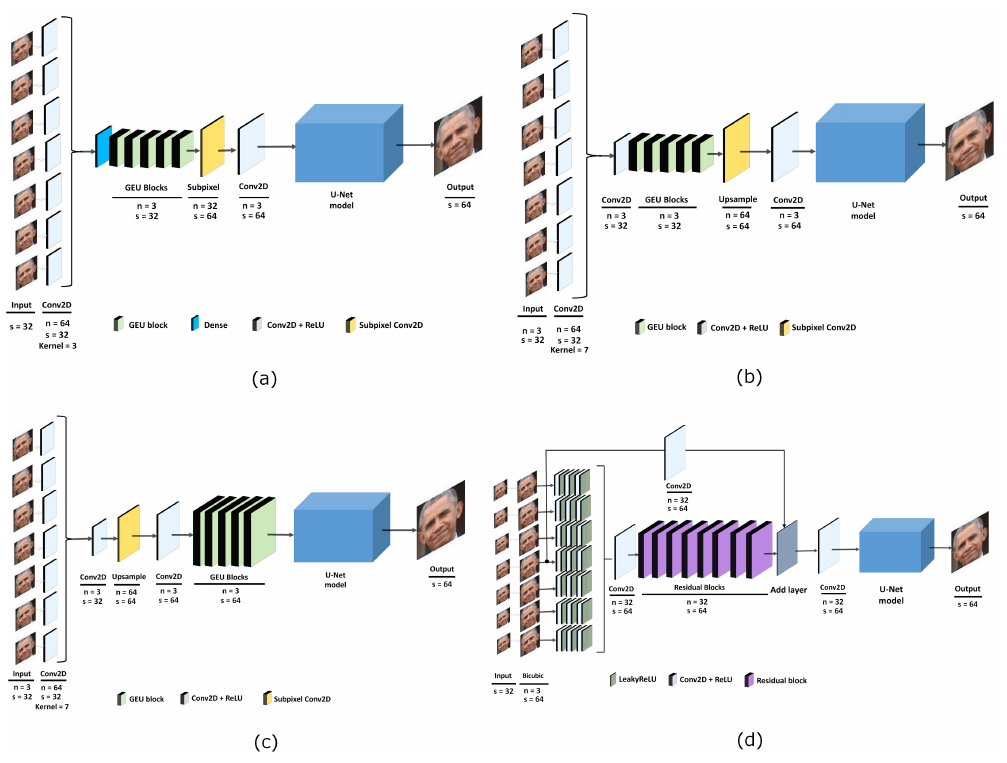
Figure 8. Overview of used neural network architectures, ( a ) U-Net+GEU, ( b ) U-Net+GEU2, ( c ) U-Net+GEU3, and ( d ) U-Net+ResBlock, where n denotes number of filters and s is features